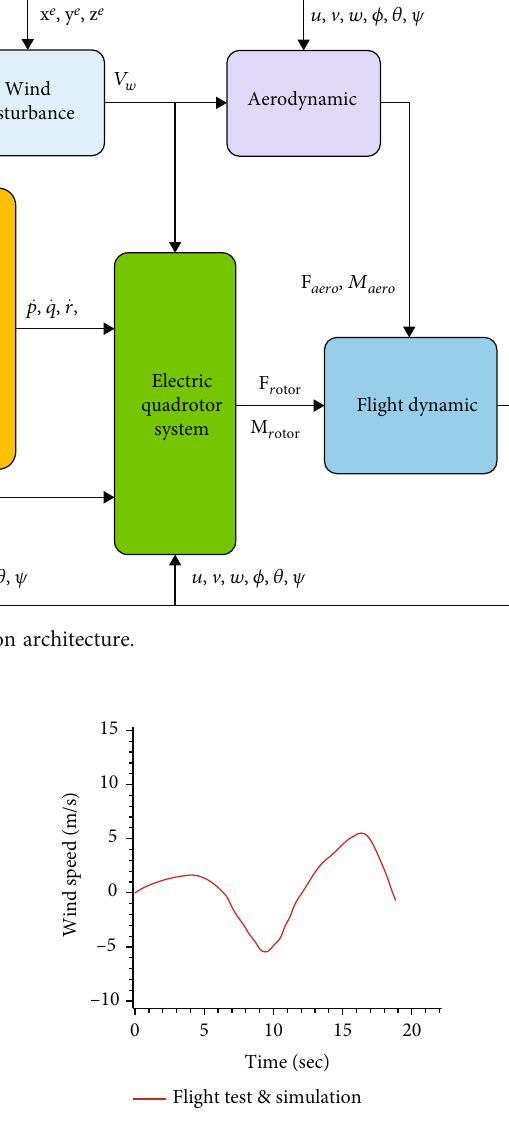
Figure 19: Wind speed measured in fl ight test, which is used as disturbance wind speed input in simulation.